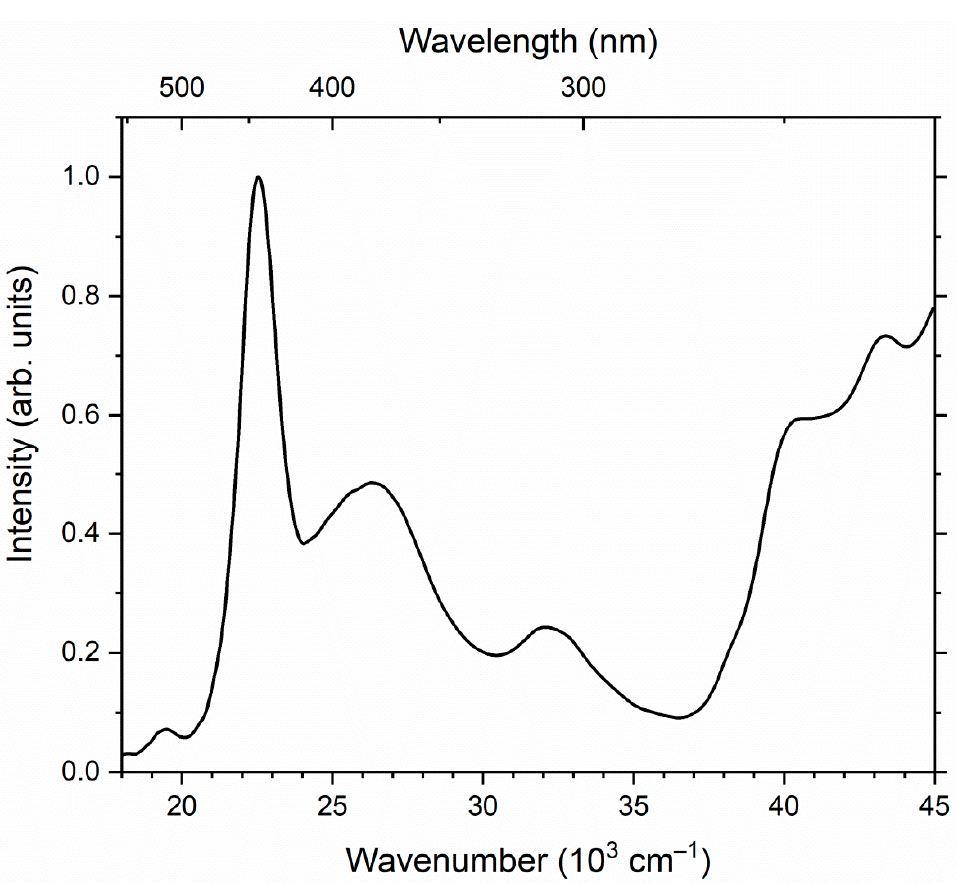
Figure 16. Excitation spectrum of afghanite (Sample 9) luminescence monitored at 16,600 cm − 1 at 77 K. Steudelite, ideally Na 4 (K 8 Na 8 Ca 7 )Ca 4 (Al 24 Si 24 O 96 )(SO 3 ) 6 F 6 ·4H 2 O [9], and alloriite, (Na,K) 26 Ca 6 (Al 24 Si 24 O 96 )(SO 4 ) 4 (SO 3 ,CO 3 ) 2 (OH) 2 ·4H 2 O [22], are also eight-layer CRAs with